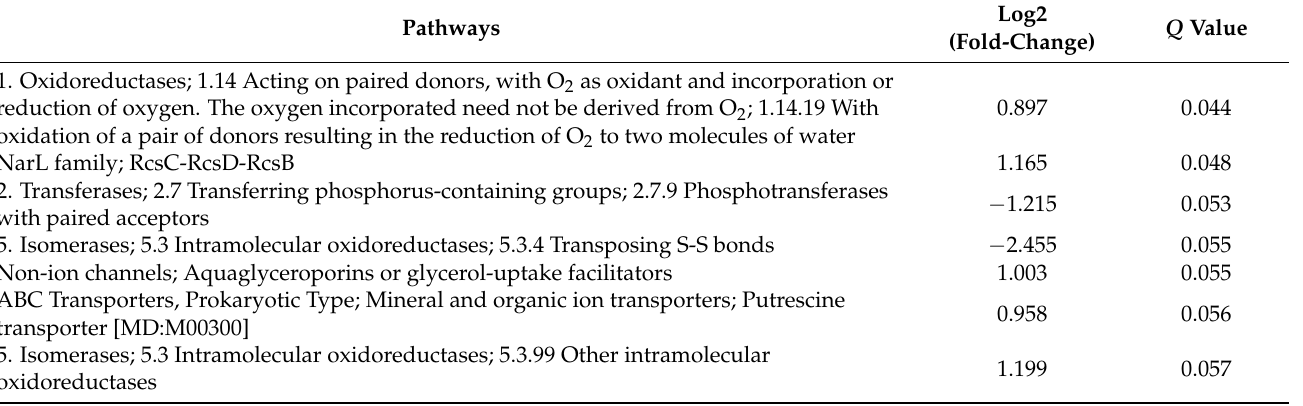
Table 9. Day 60 comparison of pathways (KO level 3) of subjects demonstrating UV resistance following grape consumption on Days 30 and 60 ( n = 3) vs. subjects demonstrating resistance to UV irradiation following grape consumption only on Day 30 ( n = 6). Pathways